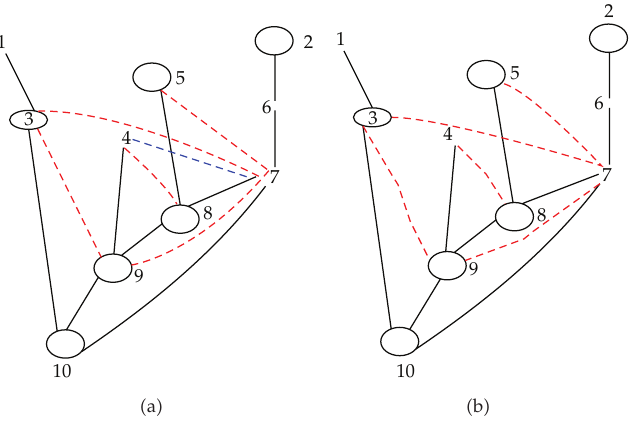
Figure 5: Hypermoral and Moral